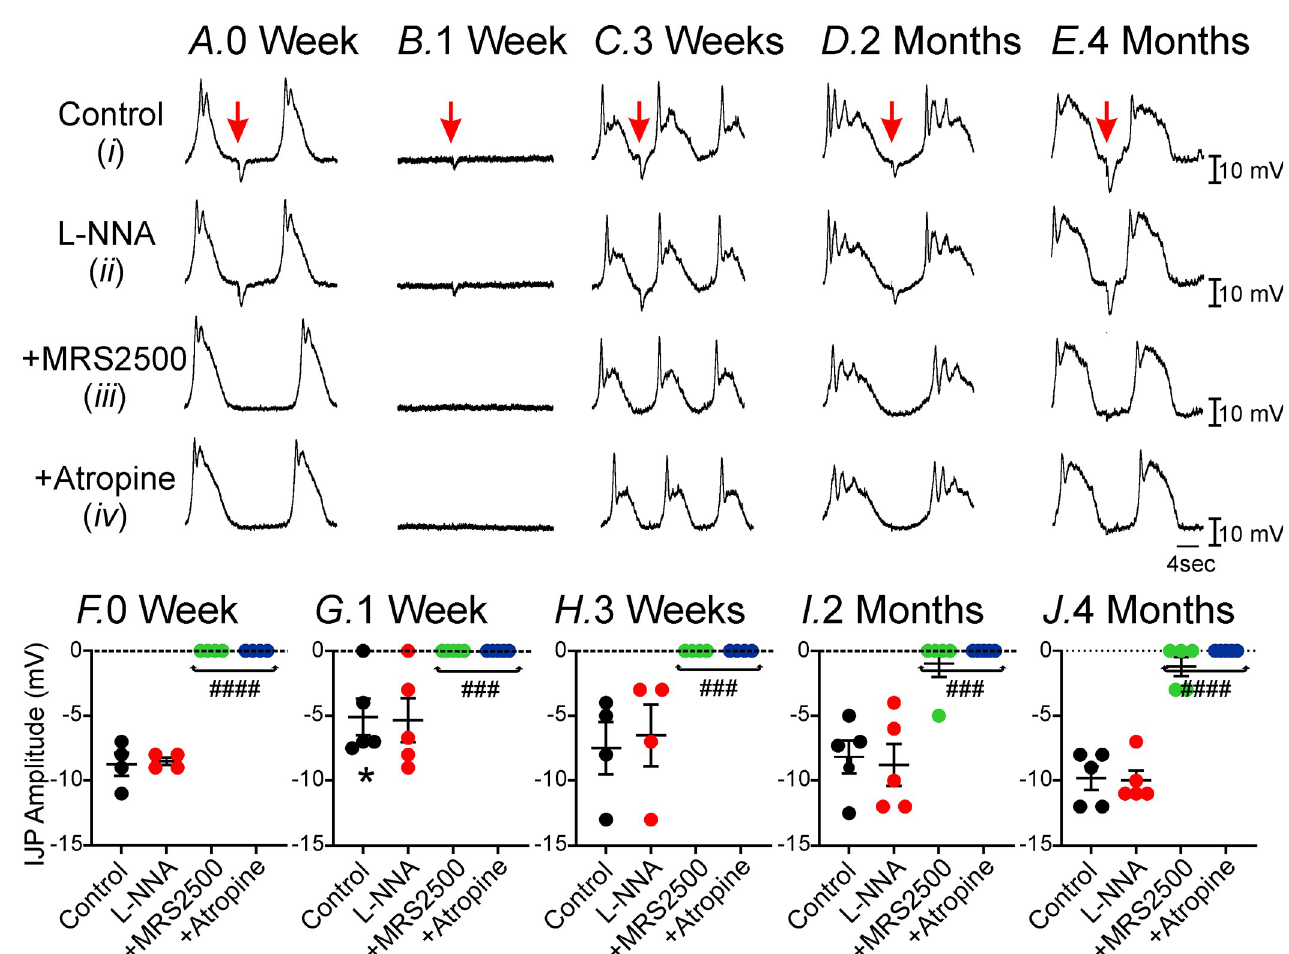
Fig 7. Changes in post-junctional neural responses in the gastric antrum post-VSG. Panel A, In control sham operated animals under control conditions (i.e. no drugs), stimulation of motor nerves (0.3 ms duration @1 Hz, for 1 second; arrows) by electrical field stimulation (EFS) evoked a fast inhibitory junction potential (fIJP; red arrow, Panels Ai&F ). In the presence of the nitric oxide synthase inhibitor L-NNA (100 μ M, Panels Aii&F ) the amplitude of the fIJP was not affected. The P2Y1 purinergic receptor inhibitor MRS2500 (1 μ M) in the presence of L-NNA, inhibited the fIJP ( Panels Aiii&F ). Application of the muscarinic antagonist atropine had no further effect on post-junctional responses (Panels Aiv&F ). Panels Bi&G, 1-week post-VSG the amplitude of the fIJP was reduced. Panels Bii&G, L-NNA (100 μ M), had little or no effect on the amplitude of the fIJP. Panels Biii&G, MRS2500 in the presence of L-NNA, inhibited the fIJP. Panels Biv&G , Application of atropine in the presence of L-NNA and MRS2500 had no further effect on the post-junctional response. Panels Ci&H, Recovery of post-junctional inhibitory responses at 3 weeks, 2 months ( Panels Di&I) and 4 months ( Panels Ei&J ). A similar pharmacological dissection was performed as in Panel A . Panels F-J, Summary of the changes in post-junctional inhibitory responses at 1 week ( G ), 3 weeks ( H ), 2 months ( I ) and 4 months ( J ), compared to controls ( F ). � P < 0.05, compared to sham controls; ### P < 0.001, #### P < 0.0001 for drug